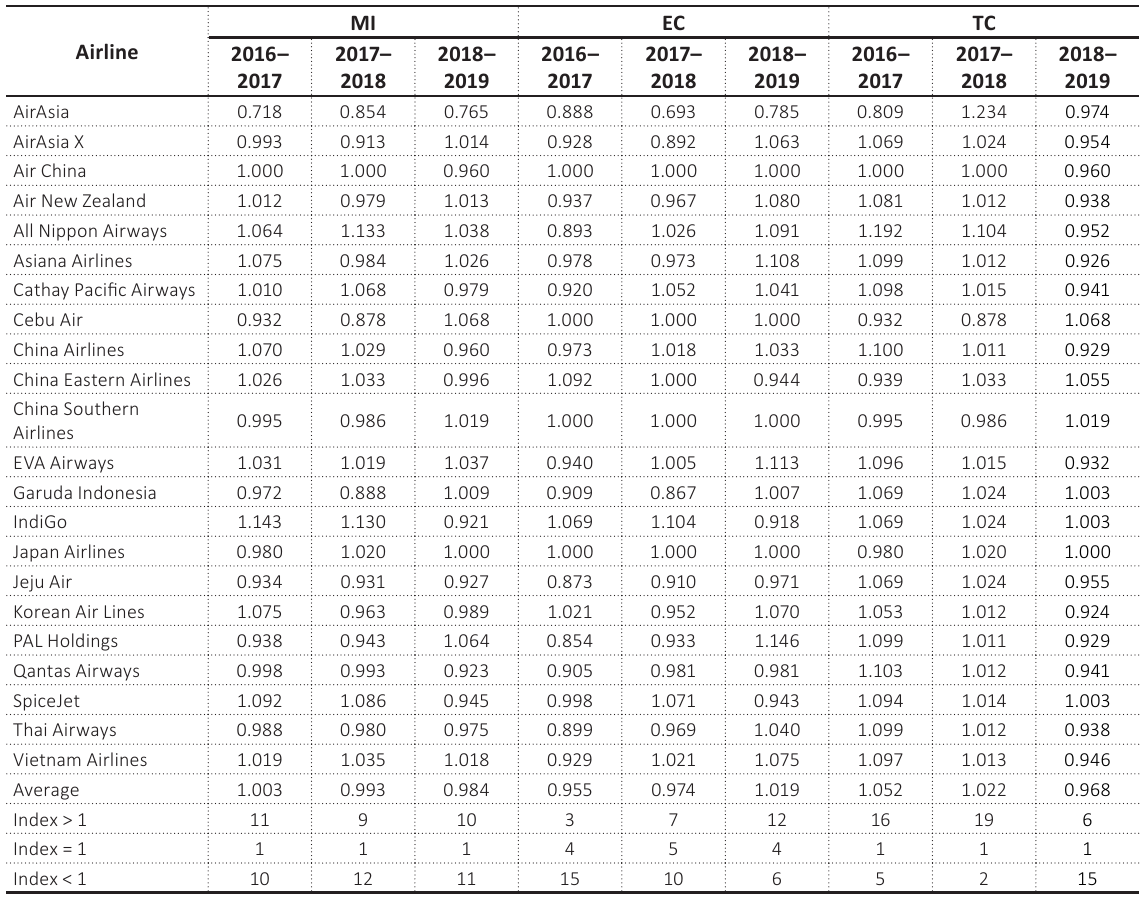
Table 4. Empirical results based on the global Malmquist productivity